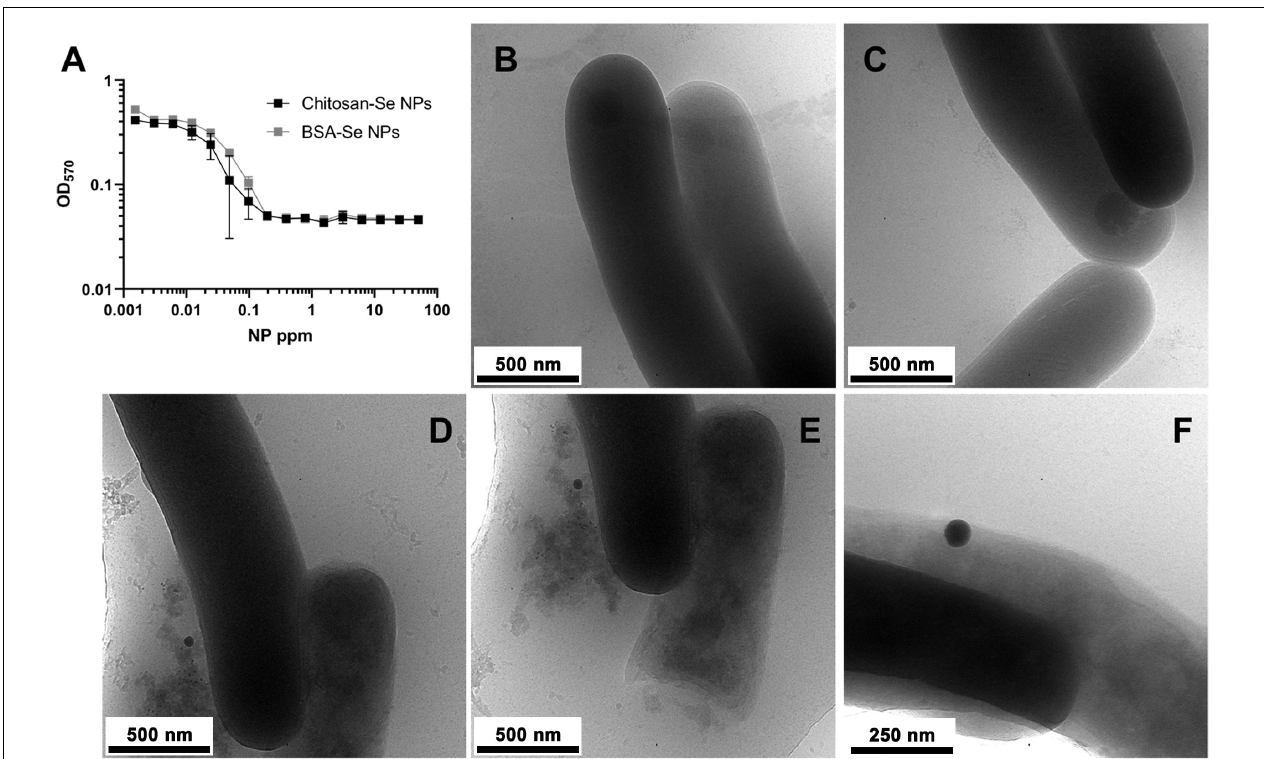
FIGURE 2 | Antimicrobial activity of SeNPs against Mycobacterium tuberculosis . (A) MIC assay testing the antibacterial activity of Ch-SeNPs and BSA-SeNPs after 20 days of treatment. (B–E) Ultrastructural analysis by cryo-EM of untreated Mtb cells (B,C) or Mtb cells treated with an inhibitory concentration (0.195 µ g/mL) of SeNPs (D–F)